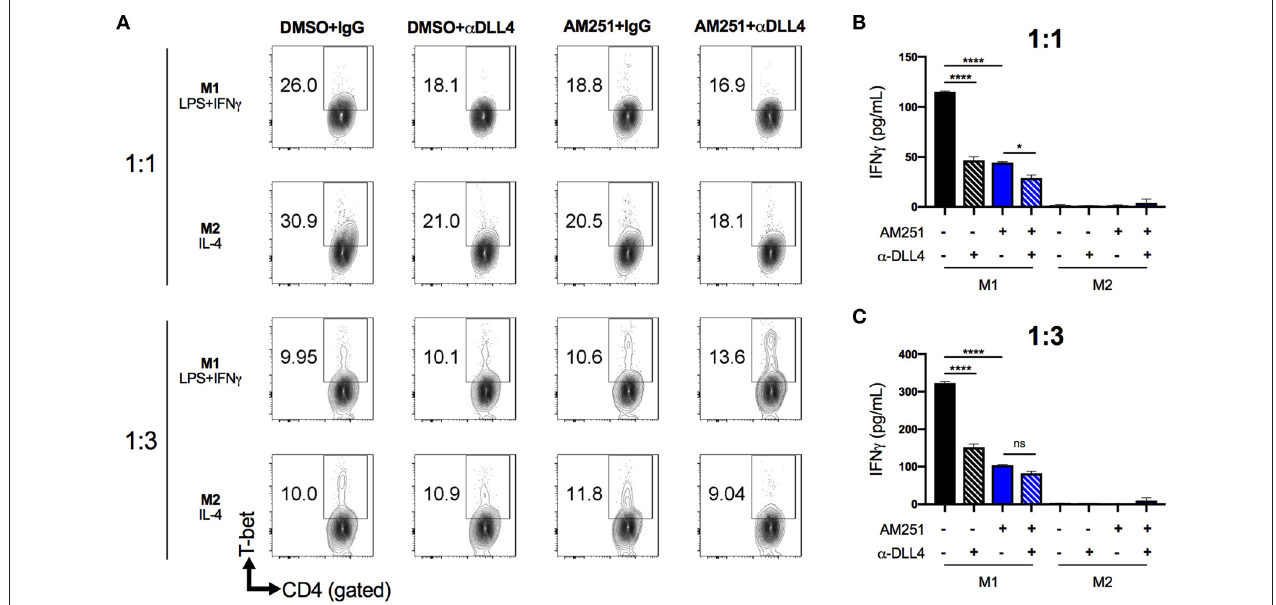
FIGURE 5 | AM251 reduces expansion of pro-inflammatory Th1 cells by downregulating DLL4 in macrophages. BMDM from naïve mice were pretreated with AM251 (10 µ M) ± α -DLL4 blocking mAb (1 µ g/mL) or vehicle/isotype controls for 1h then polarized to M1 (LPS + IFN γ ) or M2 (IL-4) for 24h. The polarization medium was then washed away and BMDM were co-cultured with naïve lymphocytes at ratios of 1:1 or 1:3 (BMDM:lymphocytes) in the presence of 1 µ g/mL ConA for 48 hr. Resulting Th1 polarization of CD4 + lymphocytes was assessed. (A) Flow cytometry of CD4 + T-bet + Th1 lymphocytes. (B,C) IFN γ concentration in cell supernatants. Data are mean ± SEM. **** p < 0.0001, * p < 0.05 by one-way ANOVA. See also Supplementary Figure 3 for lymphocyte ConA